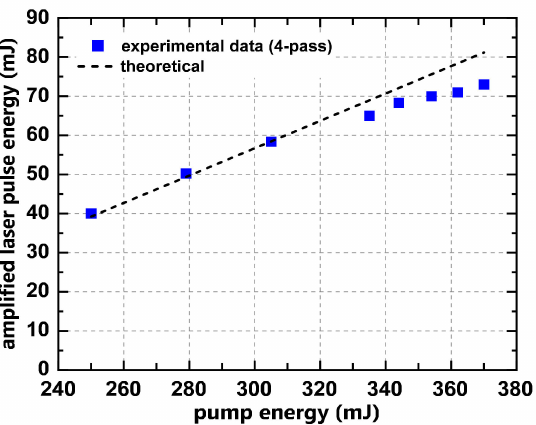
Figure 2. Measured laser pulse energy after 4-pass amplification (blue squares) and theoretical calculation using the Frantz–Nodvik equation [20,21] (black dotted line). The amplification efficiency (slope of the fitting line for the experimental data points) is